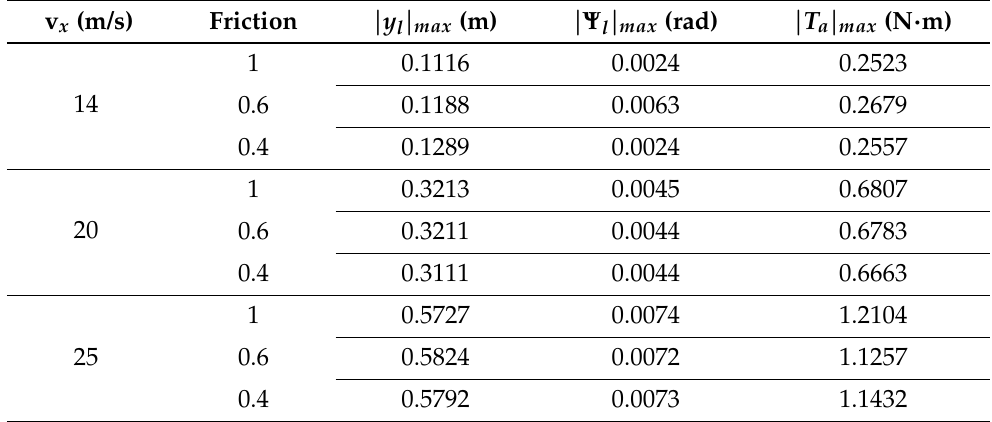
Table 3. Influence of speed variation and friction on the performance of the lane-keeping